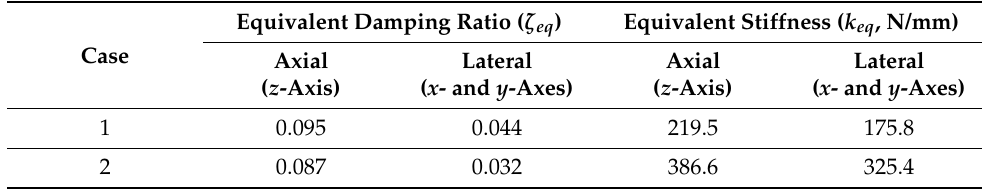
Table 3. Static Load Test Results of the Proposed WSVI.